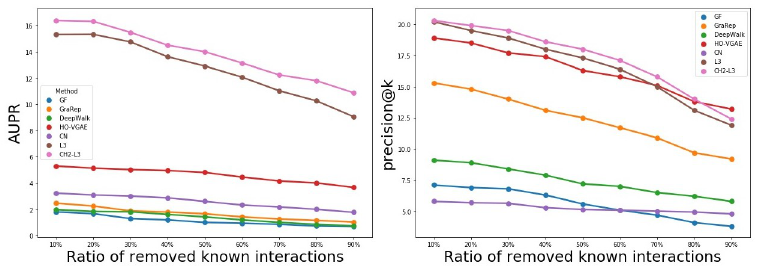
Fig 3. The results of six link prediction methods on the HI-III dataset of different incompleteness.